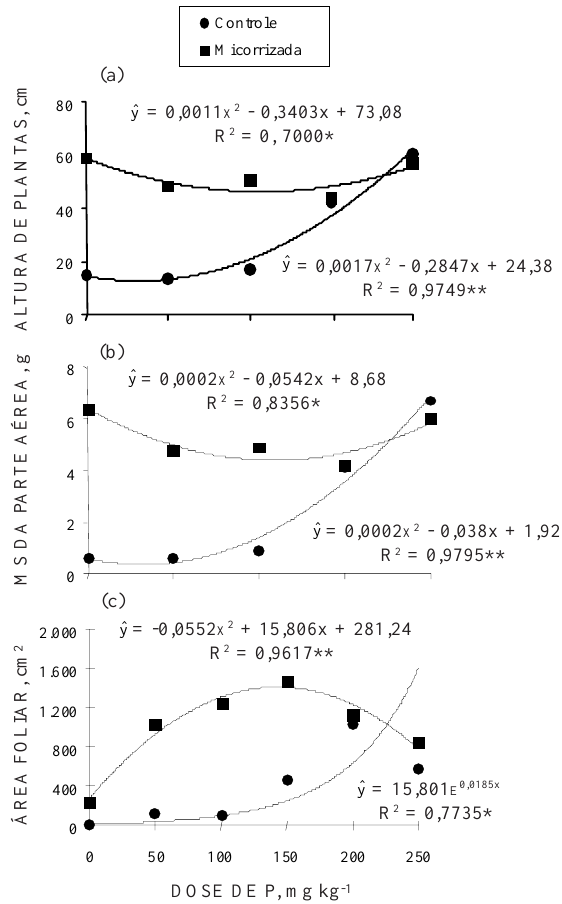
Figura 1. Altura de plantas (a), matéria seca da parte aérea (MS) (b) e área foliar (c) da tangerineira “Cleópata” inoculadas ou não com fungo micorrízico arbuscular e cultivadas com diferentes doses de